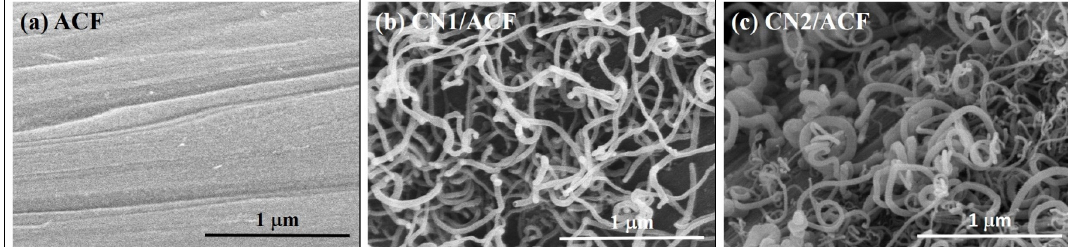
Figure 1. FESEM images of the samples: ( a ) as-received activated carbon fibers (ACF); ( b ) ACF grafted with N-doped carbon nanotubes (CN1/ACF); ( c ) ACF pre-immersed with cobalt(II) acetate and grafted with N-doped carbon nanotubes (CN2/ACF).